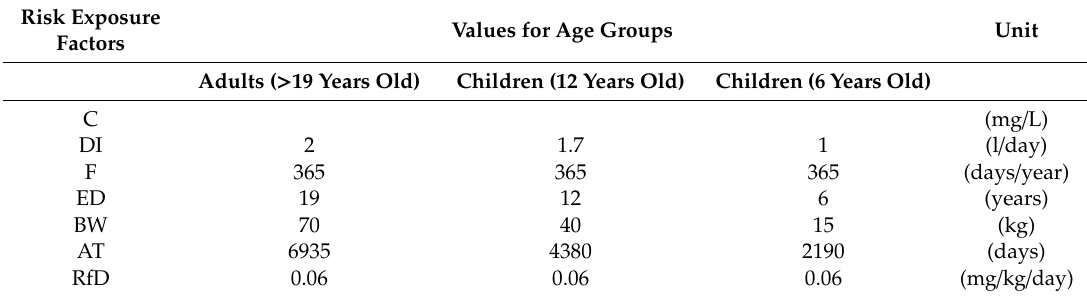
Table 1. Values used to calculate the hazard quotient (HQ) for the study area water points per age group (adapted from: [38,39]). ‘C’ values are not included as they represent individual fluoride concentrations for each water point and vary from water point to water point.